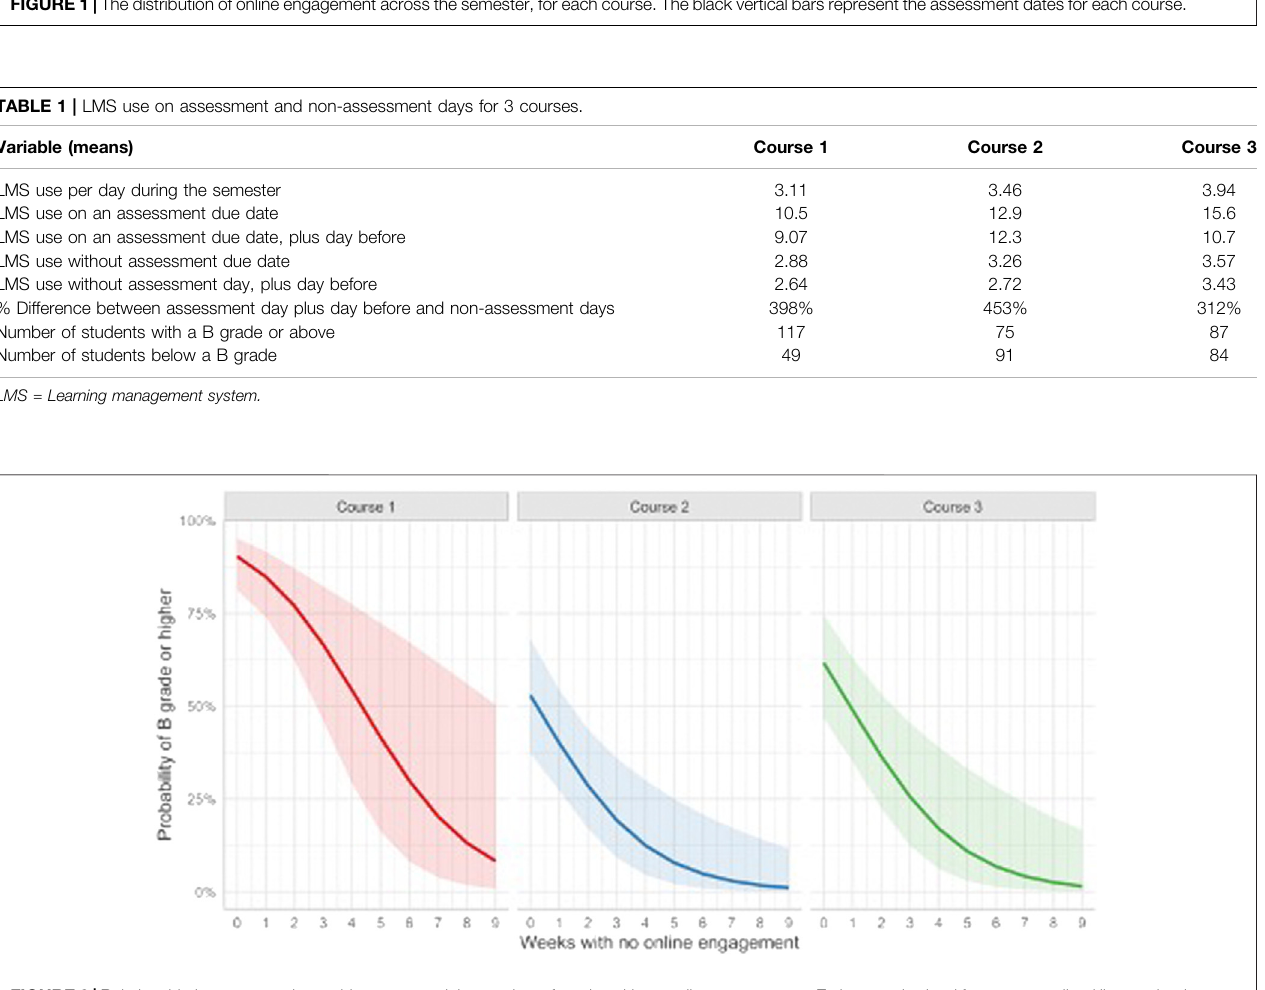
Frontiers in Education |